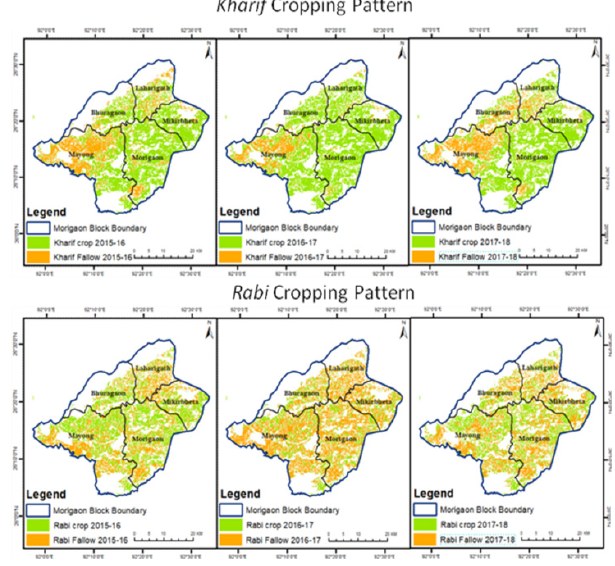
Figure 3 Season-wise Cropping pattern